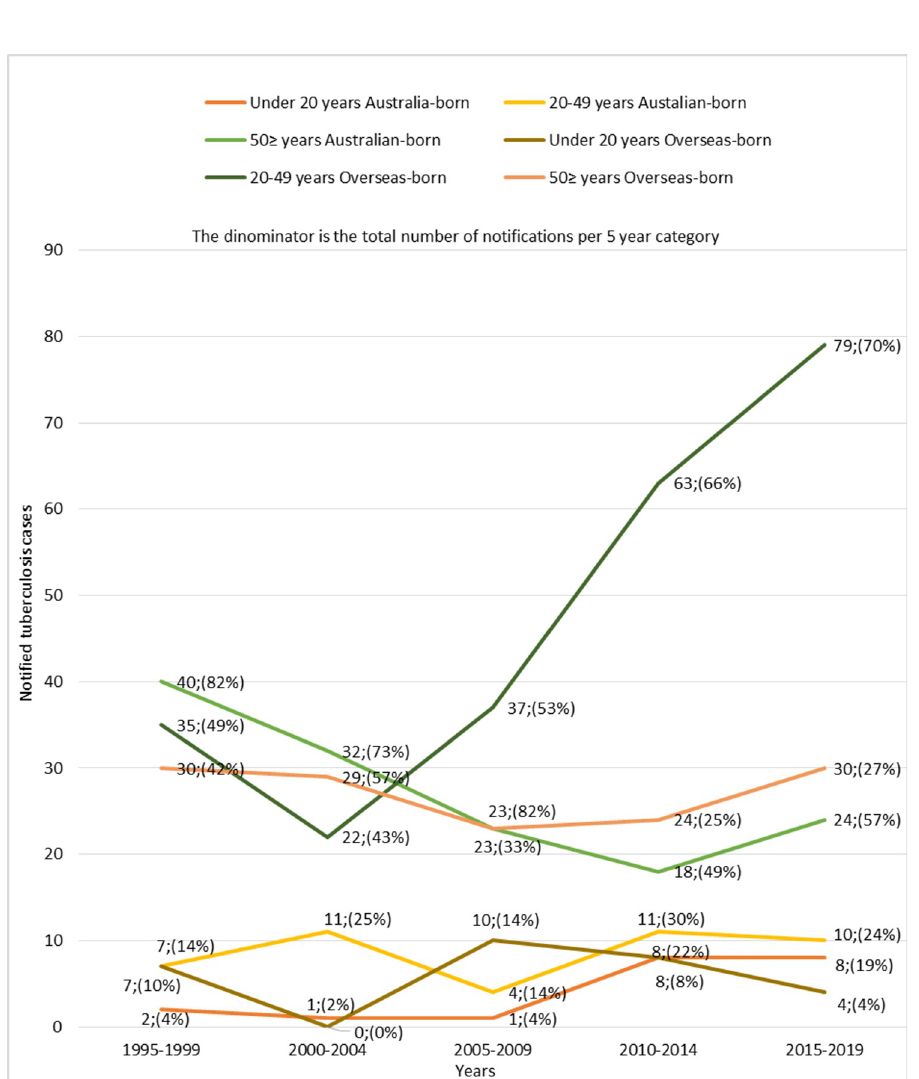
Fig 2. Tuberculosis cases in regional Victoria by year of notification, age, and country of birth from 1995 to 2019.